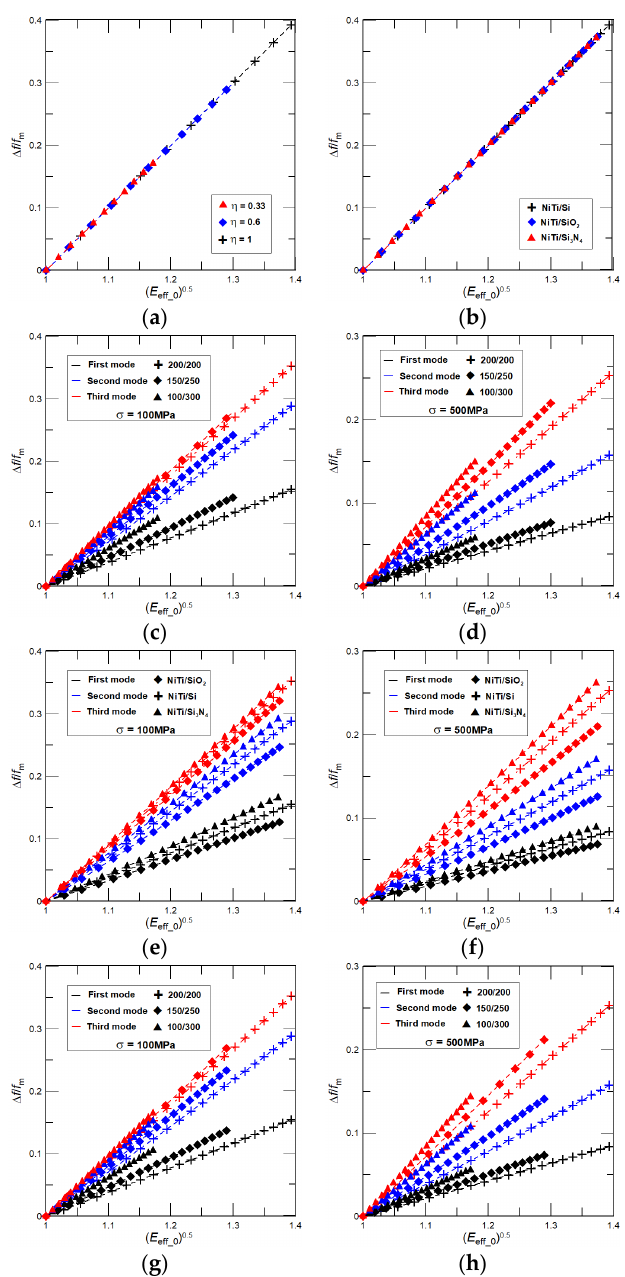
Figure 4. Relative frequency shift Δ f / f m as function of ( E eff_0 ) 0.5 calculated for: ( a ) σ = 0 and a NiTi/Si nanocantilever of different thickness ratios η = 0.33, 0.6, and 1; ( b ) σ = 0 and NiTi/Si, NiTi/SiO 2 , and NiTi/Si 3 N 4 nanocantilevers of η = 1. Both results show independency of Δ f / f m on the cantilever geometry and properties (as predicted by theory). The dependence of Δ f / f m on ( E eff_0 ) 0.5 by Equation (11) for the NiTi/Si nanocantilever of η = 0.33, 0.6, and 1, and ( c ) σ = 100 MPa, and ( d ) σ = 500 MPa. The dependence of Δ f / f m on ( E eff_0 ) 0.5 was calculated by Equation (11) for NiTi/Si, NiTi/SiO 2 , and NiTi/Si 3 N 4 nanocantilevers of η = 1 and ( e ) σ = 100 MPa, and ( f ) σ = 500 MPa. Δ f / f m as a function of ( E eff_0 ) 0.5 for the NiTi/Si nanocantilever of L = 10 μ m, W = 900 nm, and η = 0.33, 0.6, and 1 predicted by FEM and ( g ) σ = 100 MPa, and ( h ) σ = 500 MPa.